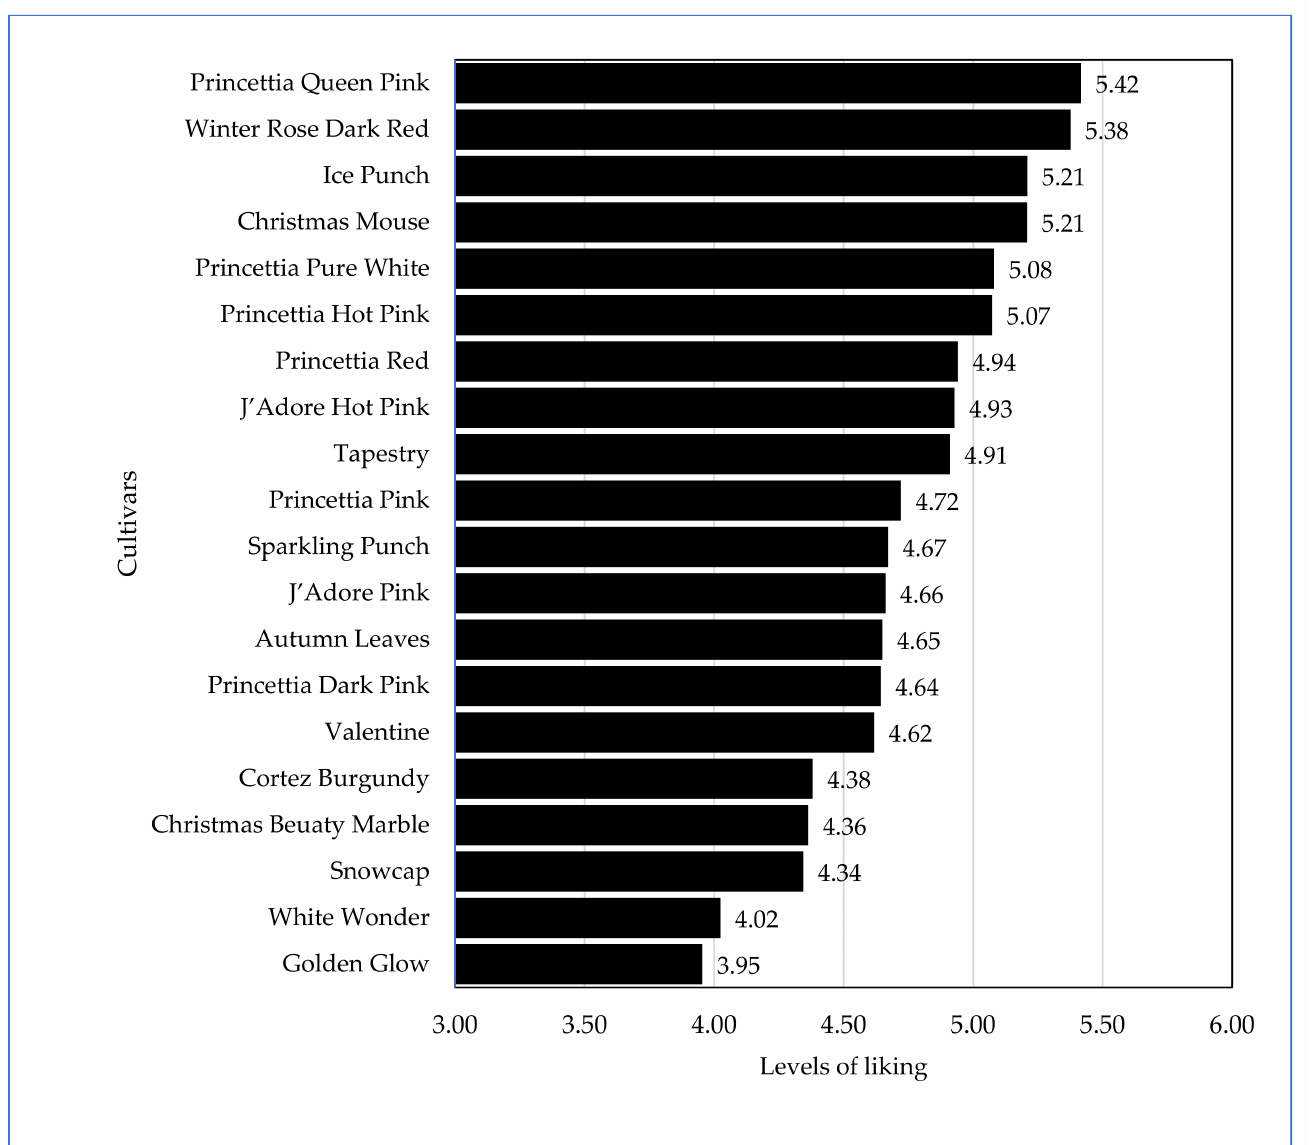
Figure 3. Levels of liking for 20 poinsettias